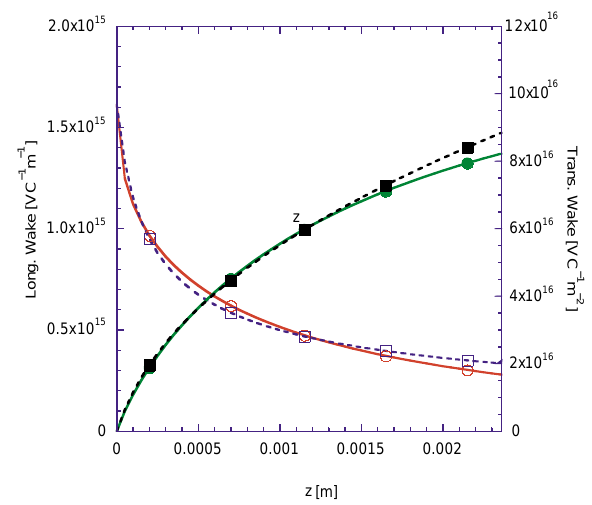
FIG. 2. (Color) Short-range longitudinal (open circles) and transverse wakefields (solid circles) in the NLC X-band accel- erator structures along with the approximations of Eqs. (22) (open squares) and (23) (solid